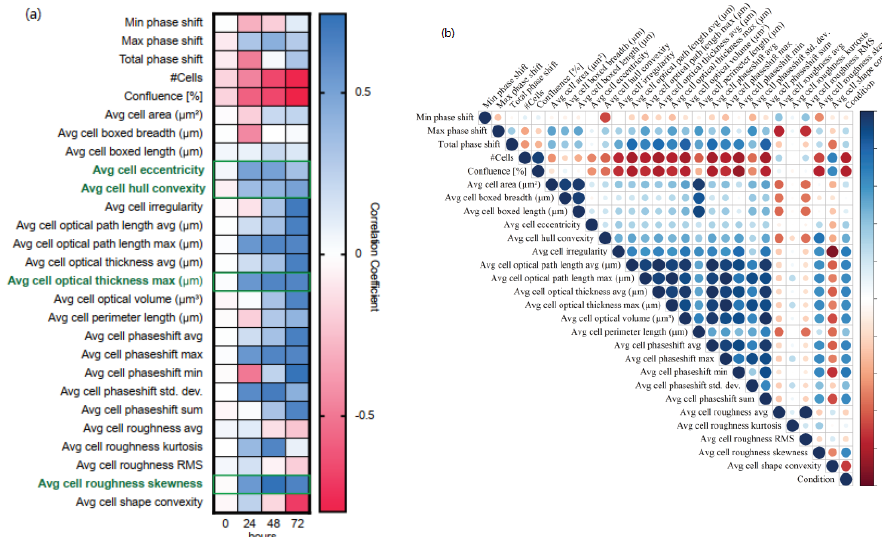
Figure 2. Correlation matrices show the Pearson correlation coe ffi cient for multiple morphological parameters obtained by digital holographic microscopy for NMuMG cells cultured under di ff erent conditions. The morphological parameters were obtained from digital holographic images acquired at 0, 24, 48, and 72 hours after initiation of the time-lapse. ( a ) The conditions were ranked based upon location in the EMP spectrum. Heatmap depicts correlation between morphological parameters and EMP rank at each timepoint. The parameters listed in bold green were selected for further analyses. ( b ) Matrix depicts correlation between all morphological features at 72 hours. Both the size of the circle and the colour intensity represent the strength of the correlation (blue = positive correlation; red = negative correlation). Three different samples were analyzed per condition using 15 images each.